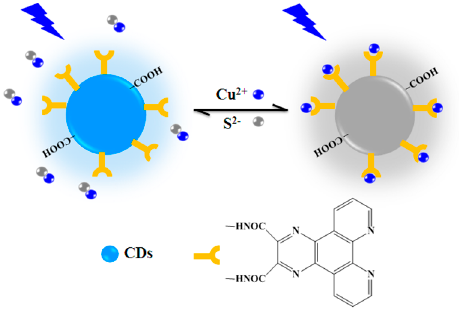
Figure1. Schematic diagram of functionalized carbon dots (FCDs) for Cu 2+ and S 2 −